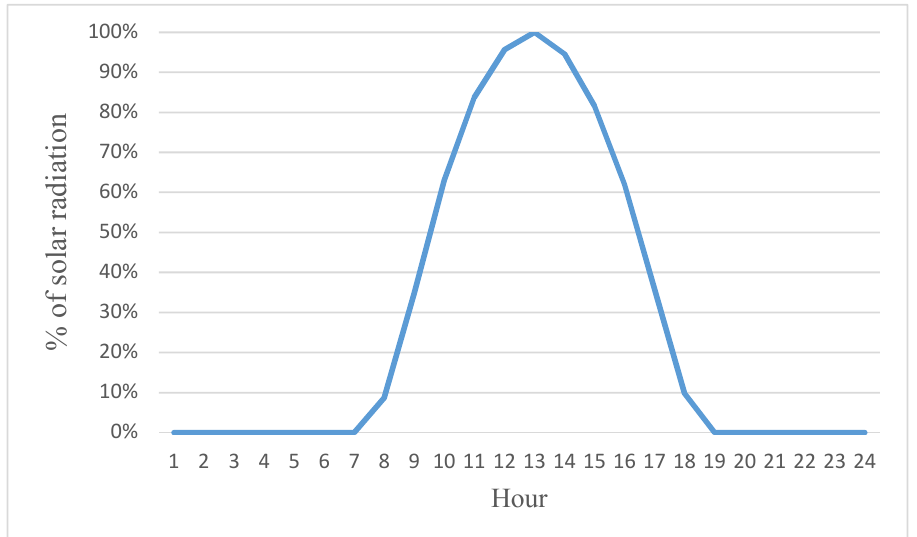
Figure 5. Hourly solar radiation curve for one day in Isla de la Juventud. Source: own elaboration with the model [28].